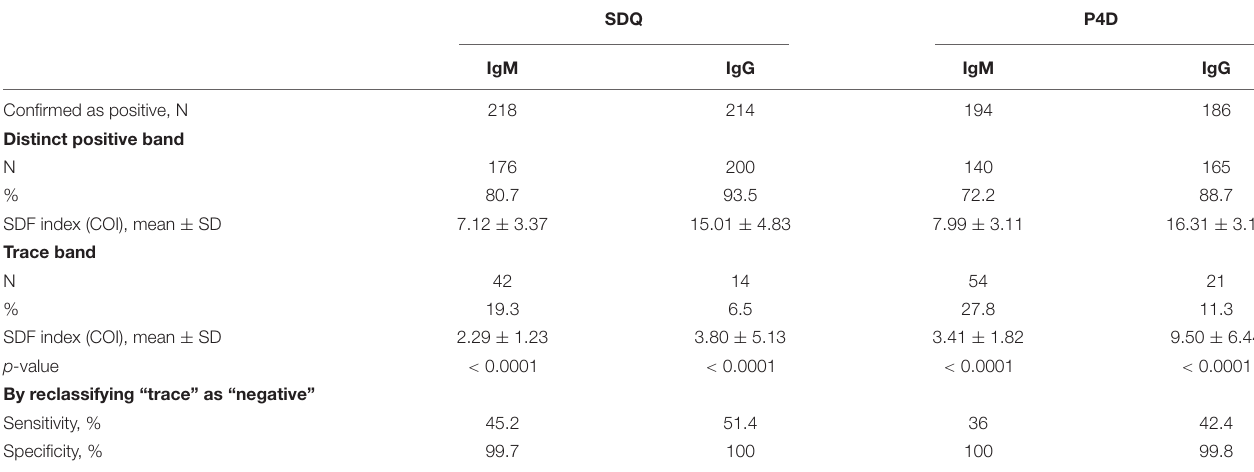
TABLE 4 | The comparison of the distinct positive bands and the trace bands in LFIAs by visual reading in compliance to the index of LFIA by fluorescence-based automated reading. SDQ